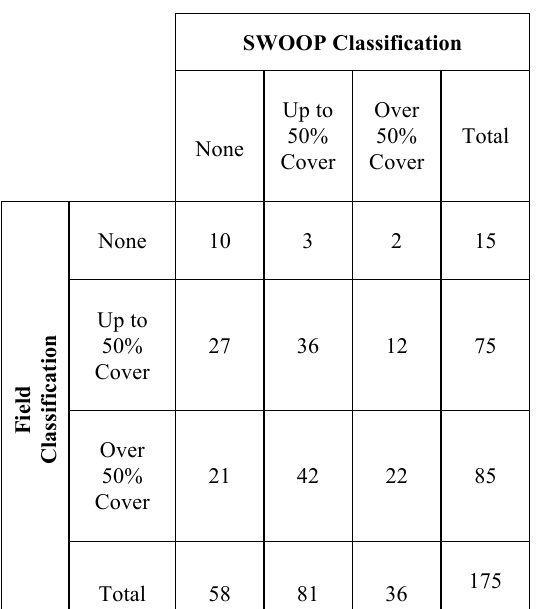
Table 4: A 3 x 3 matrix comparing the SWOOP classifications to the field classifications for percent cover of submerged aquatic vegetation ( p = 1.0).